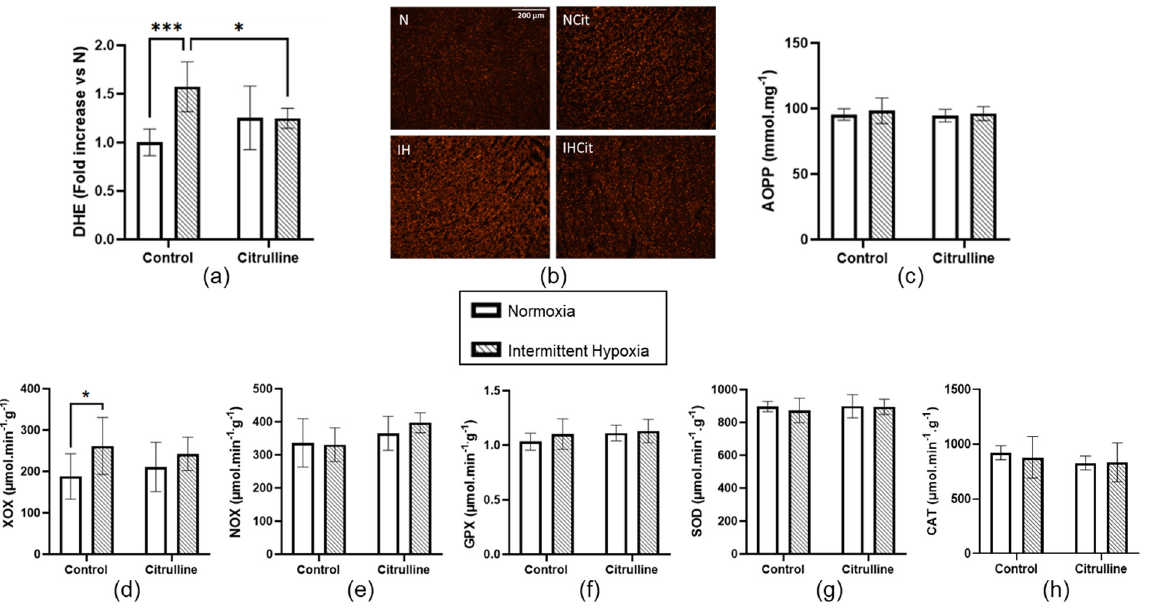
Figure 5. Citrulline decreased the intermittent hypoxia (IH)-induced increase in superoxide anion content in the heart. ( a ) DHE levels with ( b ) representative images (×100); ( c ) Concentration of advanced oxidation protein products (AOPP) in mmol·mg − 1 of protein; ( d ) Activities of xanthine oxidase (XOX), ( e ) NADPH oxidase (NOX), ( f ) glutathione peroxidase (GPX), ( g ) superoxide dismutase (SOD) and ( h ) catalase (CAT) expressed in µmol·min − 1 ·g − 1 of protein ( n = 5–6) of rats exposed to normoxia (N) or IH supplemented with 1 g·kg − 1 ·d − 1 citrulline (Cit) or not (Control). Values are represented as mean ± SD. Two-way ANOVA followed by Fisher’s LSD test. * p < 0.05, *** p <